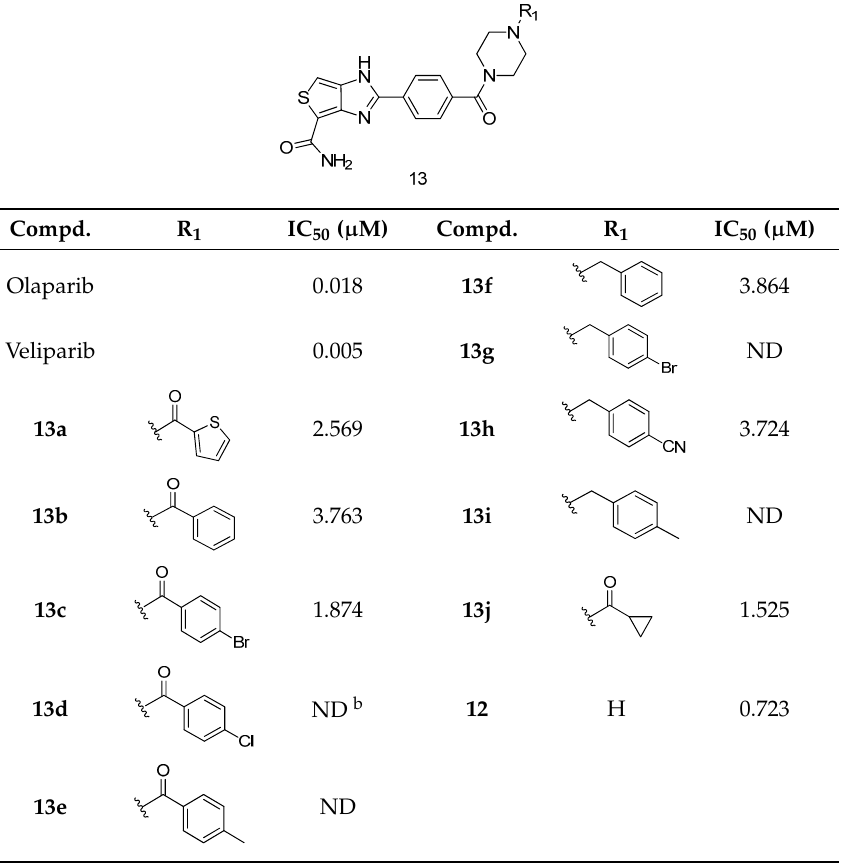
a : IC 50 values were calculated by logit method from the results using six concentrations for each compound. b : ND: not determined. IC 50 of the compounds with <50% PARP-1 inhibitory ratios at 10 μ M was not determined.